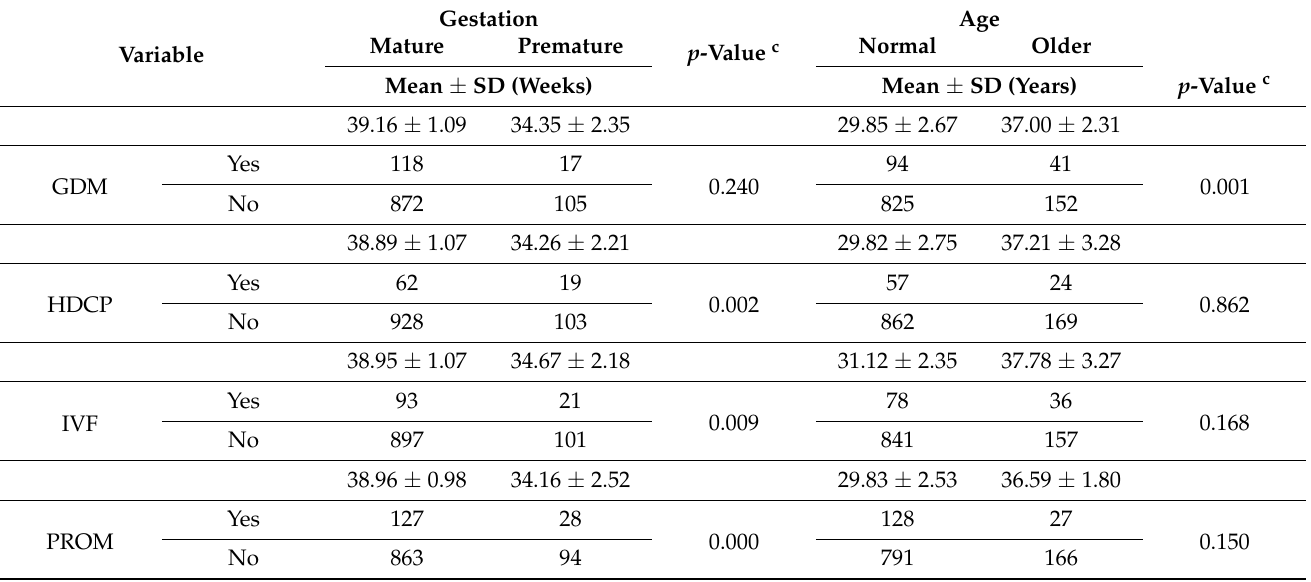
Table 2. Analysis of the associations between premature birth and advanced age with pregnancy- related diseases in SCH patients.